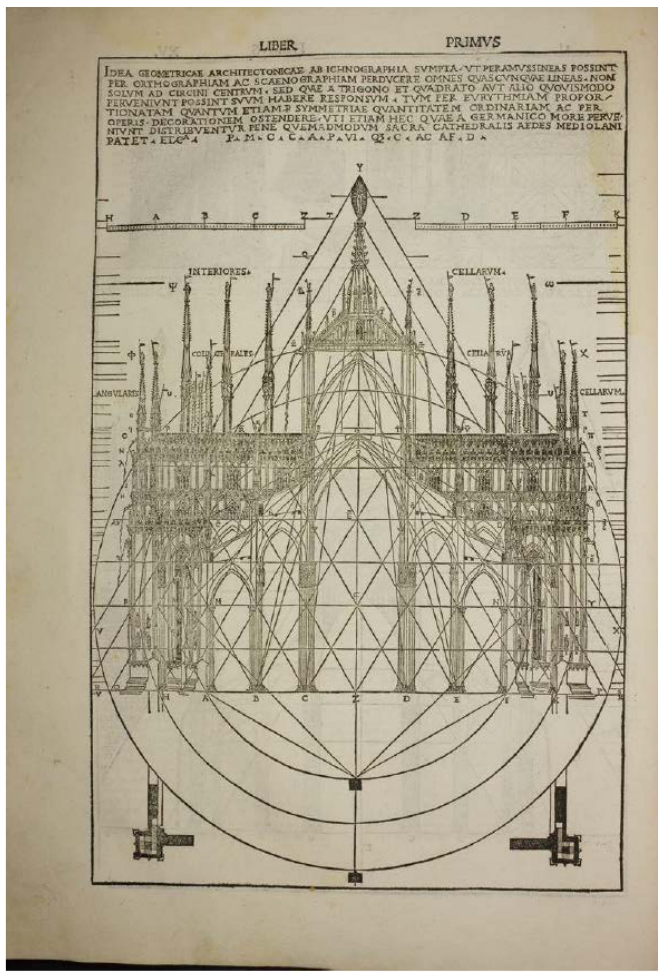
Figure 8. Cesare Cesariano, Scaenographia of the Duomo, Milan. From Cesare Cesariano, Di Lucio Vitruvio Pollione de architectura ... (Como, 1521) Book 1, folio XV verso.